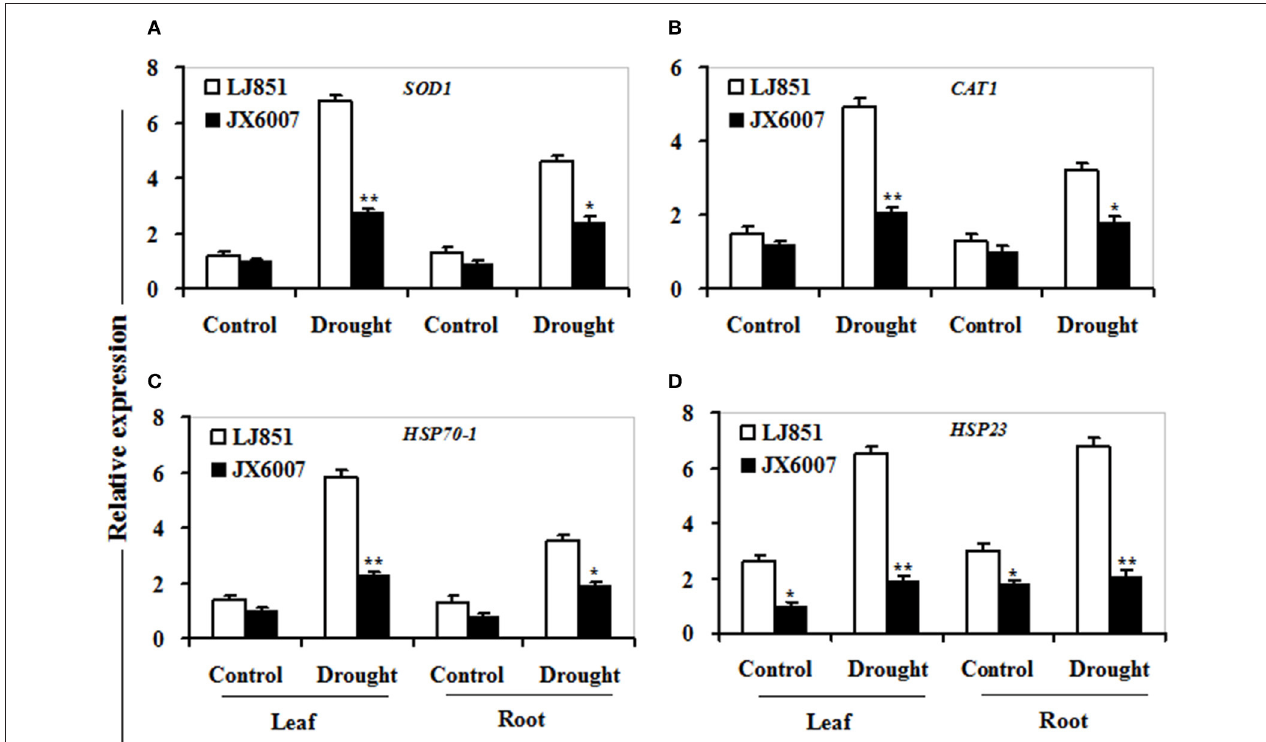
FIGURE 8 | Transcriptional expression of antioxidant-related and chaperon proteins in leaf and root under drought stress. RNA was extracted from 10-day stressed leaves and roots and reverse-transcribed to synthesize cDNA, which was used for qPCR analysis with primers specific for four genes SOD1 (A) , CAT1 (B) , HSP70-1 (C) , and HSP23 (D) . Data represented means ± SE of three biological replicates. Bar indicates SE. ** t -test, with P < 0.01; * t -test, with P <